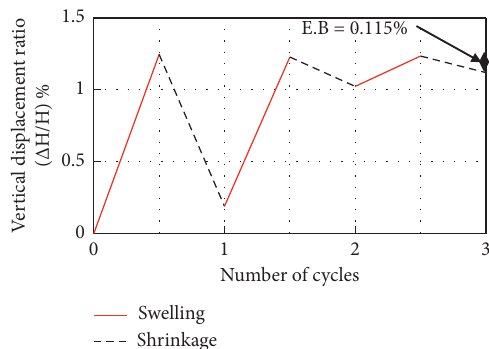
Figure 11: Vertical displacement ratio versus the number of cycles for TECS with SCP.